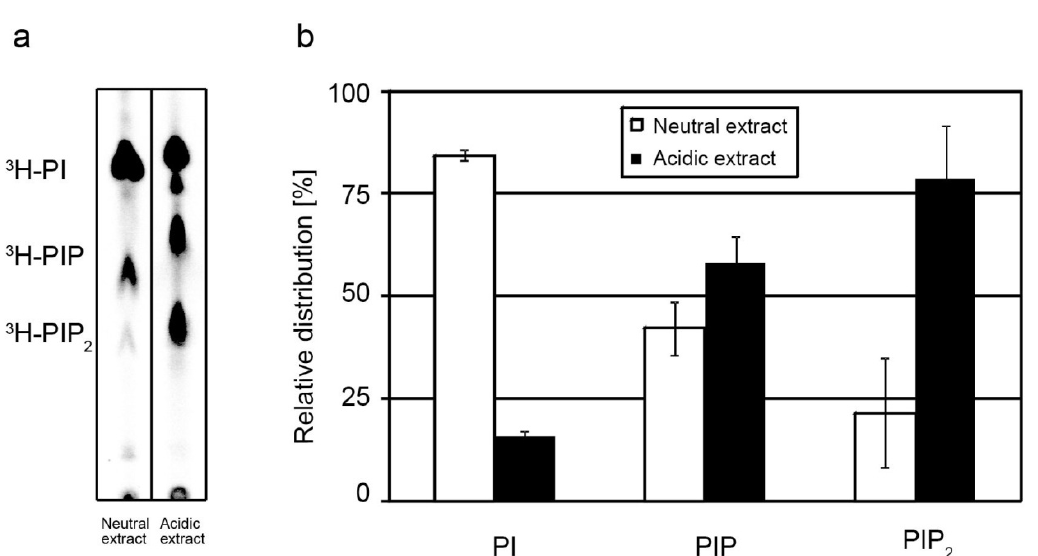
Figure 1. Recovery of endogenous PIPs. HeLa cells were metabolically labeled with myo -[ 3 H]-inositol. Following a two-step lipid extraction, 3 H-labeled inositol lipids were separated by TLC and visualized by autoradiography. Autoradiogram ( a ) and quantification ( b ) showing the distribution of 3 H-PI and 3 H-PIPs between neutral and acidic extracts. To avoid saturation of the detector, maximal 200 nCi were used for TLC analysis. For quantification, the spot intensities were extrapolated to determine the absolute amounts of PI and PIPs in lipid extracts. Data represent mean values ± SD of four independent